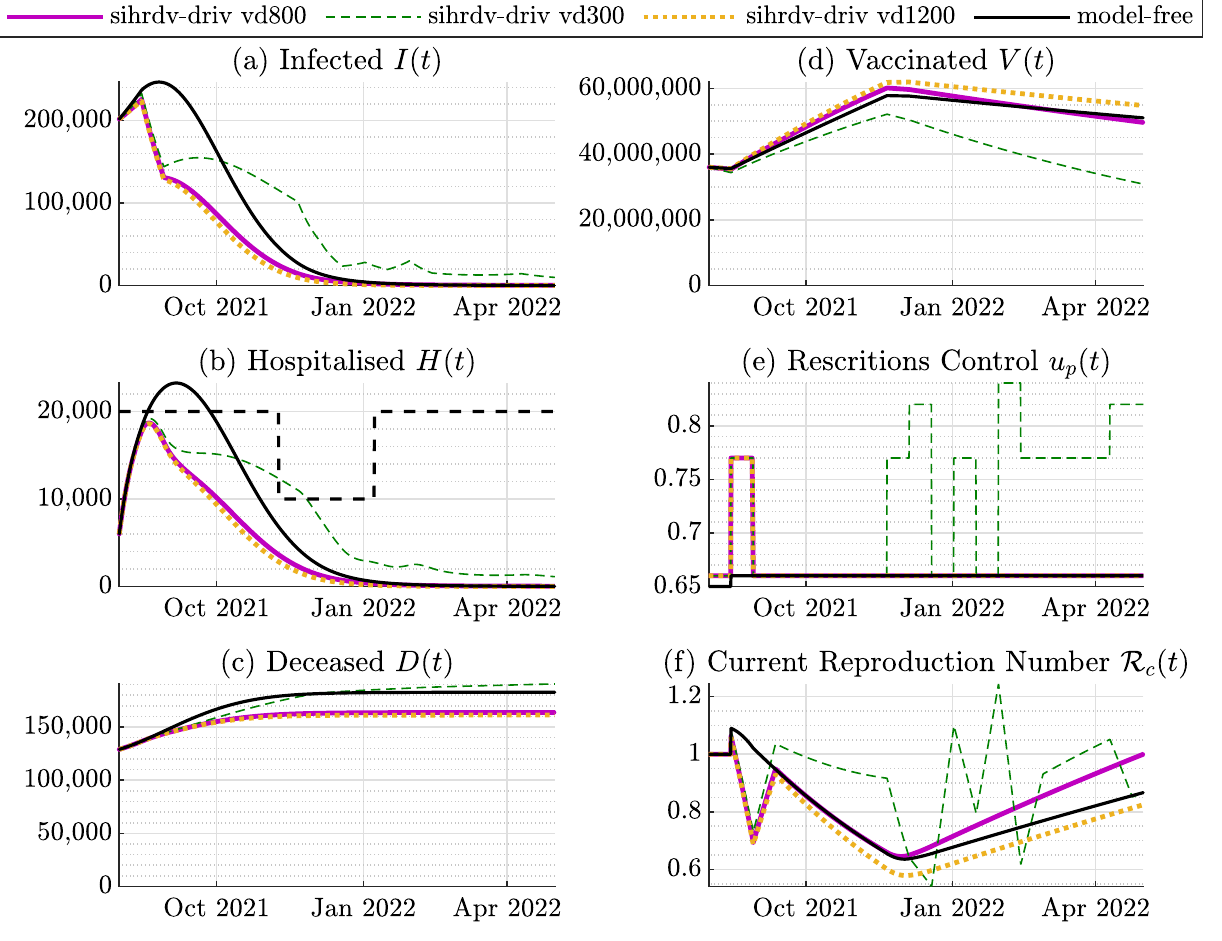
Figure 4. Time histories of the perspective test: August 2021-May 2022. No new COVID-19 variants. The basic reproduction number is kept equal to R 0 = 7 (Delta Variant). The purple line named sihrd-driv vd800 represents our SIHRD-V model-driven results with a vaccination immunity decay time constant of 800 days. We also include the SIHRD-V model-driven results with a vaccination immunity decay time constant of 300 days (the green dashed line named sihrd-driv vd300), and of 1200 days (the orange dotted line named sihrd-driv vd1200). The black line represents the model-free intervention policy, i.e. without any restrictions adjustment. The black dashed line represents the chosen time-varying threshold for the hospitalised population. The hospitalised population remains below the maximum accepted time-varying threshold with the use of our intervention